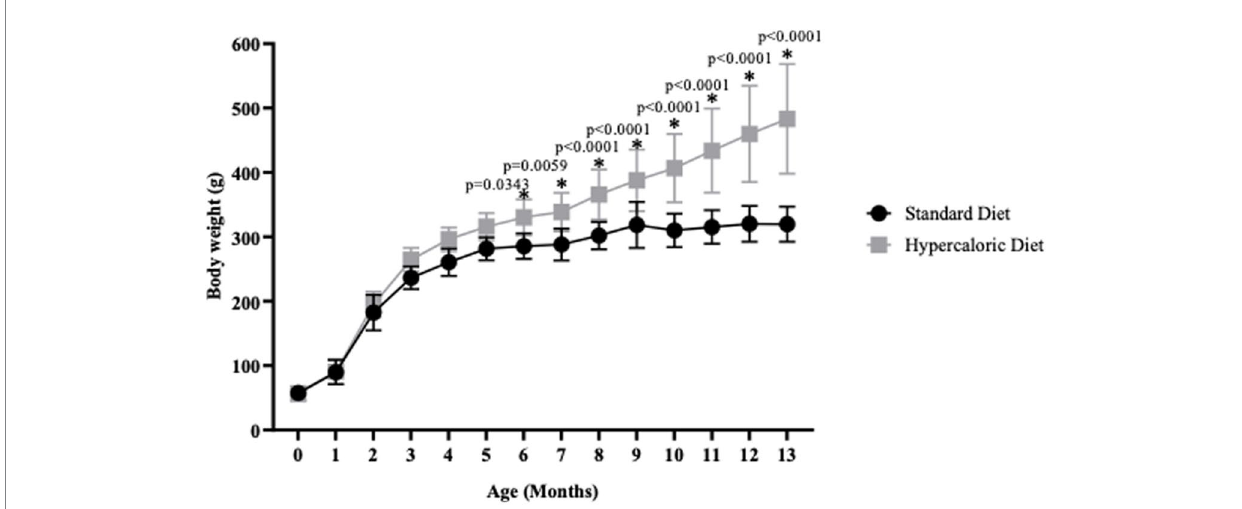
FIGURE 1 Body weight. Animal body weight was evaluated monthly ( n = 17 SD and n = 15 HD). The data represent the mean ± standard deviation (SD) and were analyzed by ANOVA and post hoc Holm-Sidak. The p -values are indicated in the graph<0.05. The significant differences between groups compared to the HD are marked with